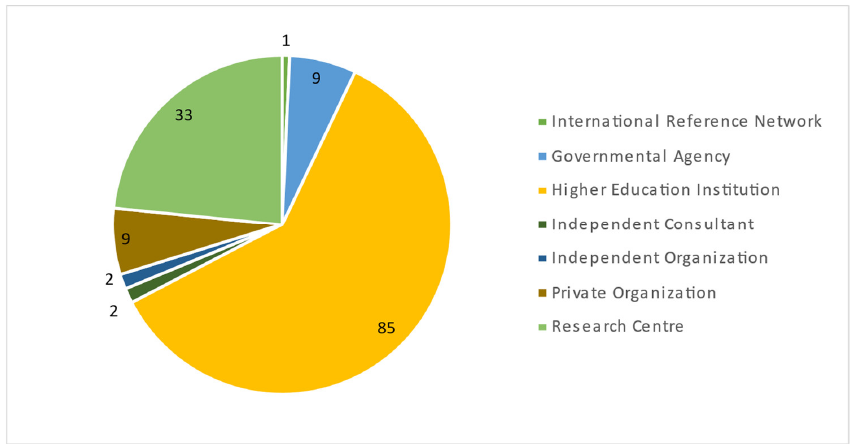
Figure 3. Number of Authors per Type of Entity.